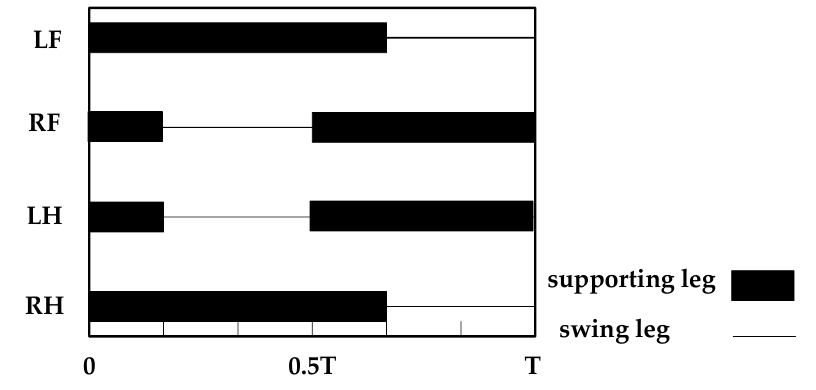
Figure 5. Gait graph for a walking trot: the black bars defines the stance phase of the left hind (LH), left front (LF), right front (RF), and right hind (RH)